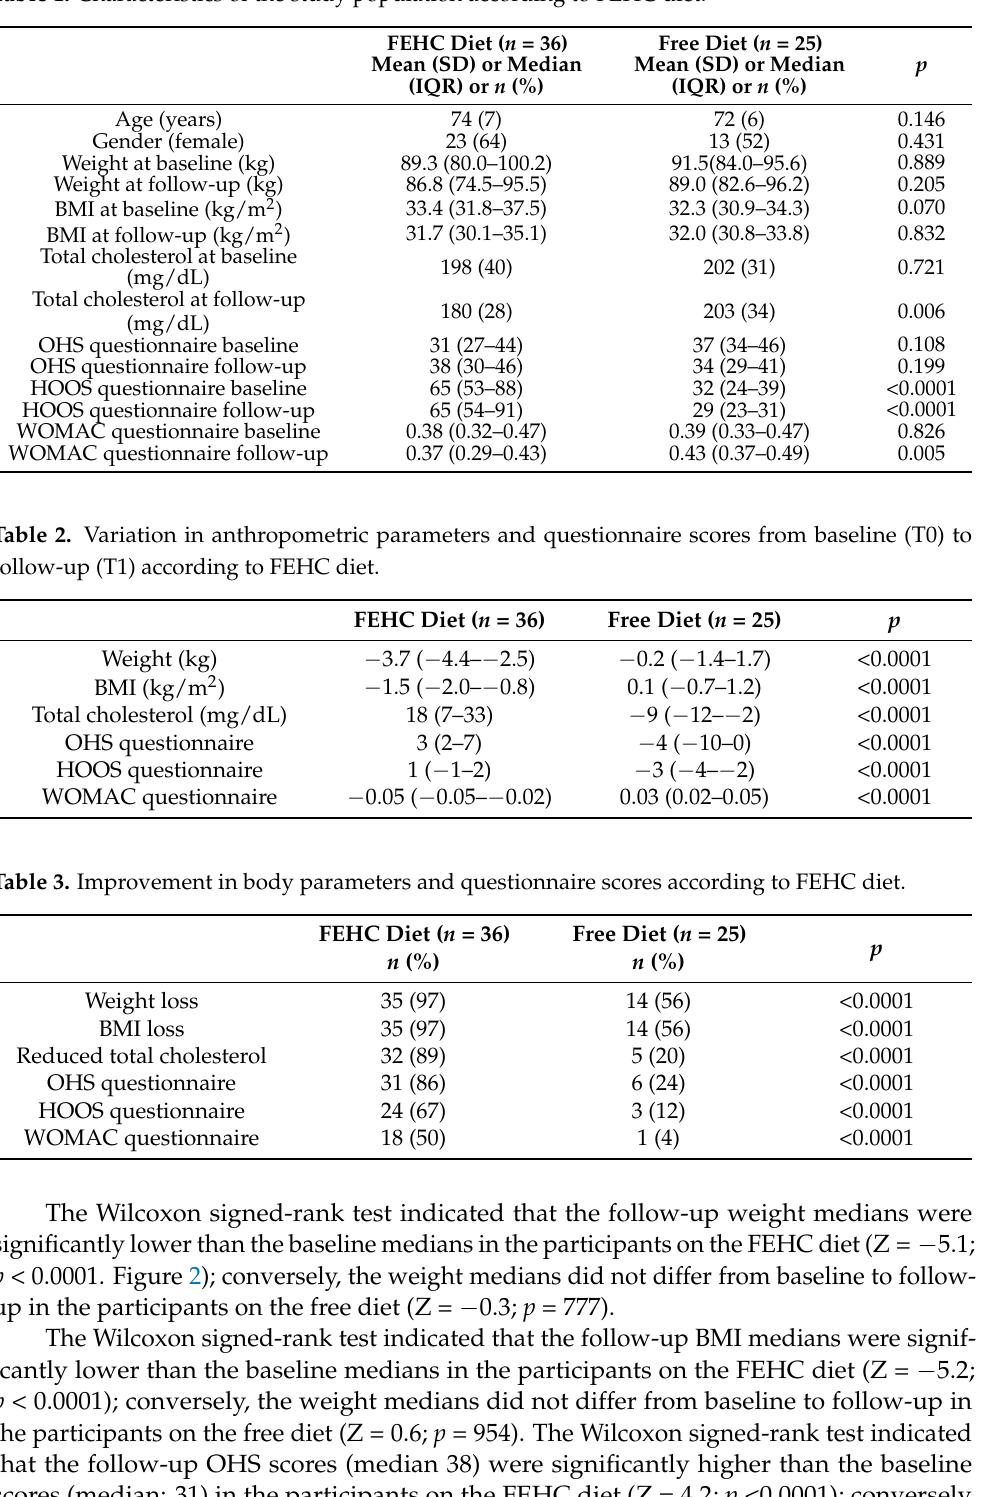
Table 1. Characteristics of the study population according to FEHC diet.